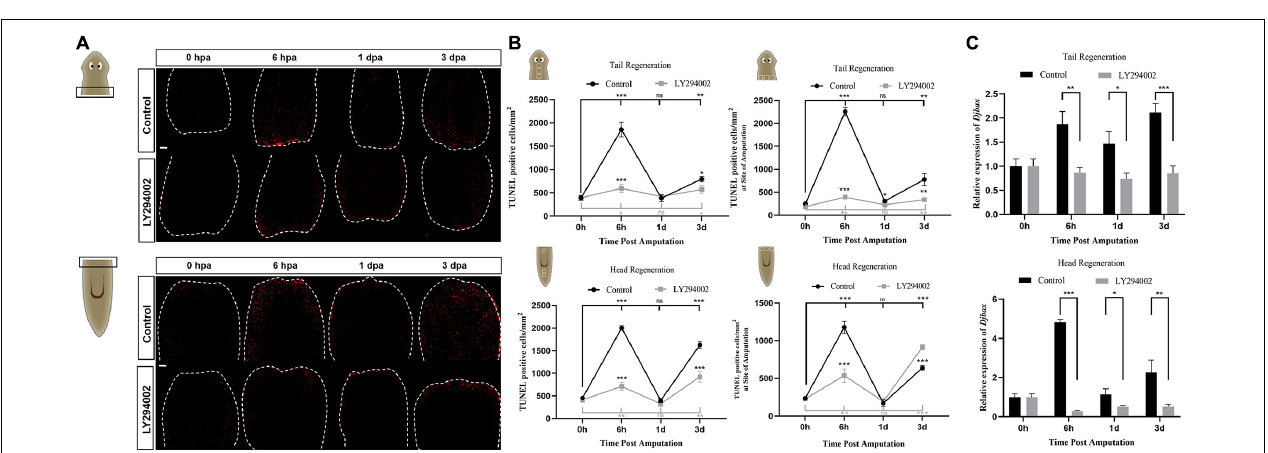
FIGURE 5 | Effect of the PI3K inhibitor LY294002 on neoblast proliferation during planarian regeneration. (A) Representative images showing mitotic activity (green dots, H3P positive cells) at 0 h, 6 h, 1 days, and 3 days post amputation. Scale bar = 100 µ m. (B) Quantification of the average number of H3P positive cells/mm 2 in the regenerating trunk fragments at indicated time point. * P < 0.05, ** P < 0.01, *** P < 0.001, and ns, not significant, by the Student’s t -test. (C) Relative expression levels of Djmcm2 gene in regenerating head and tail fragments. The expression level of Djmcm2 at 0 hpa was set to one. * P < 0.05, ** P < 0.01, and *** P < 0.001, by the Student’s t -test.